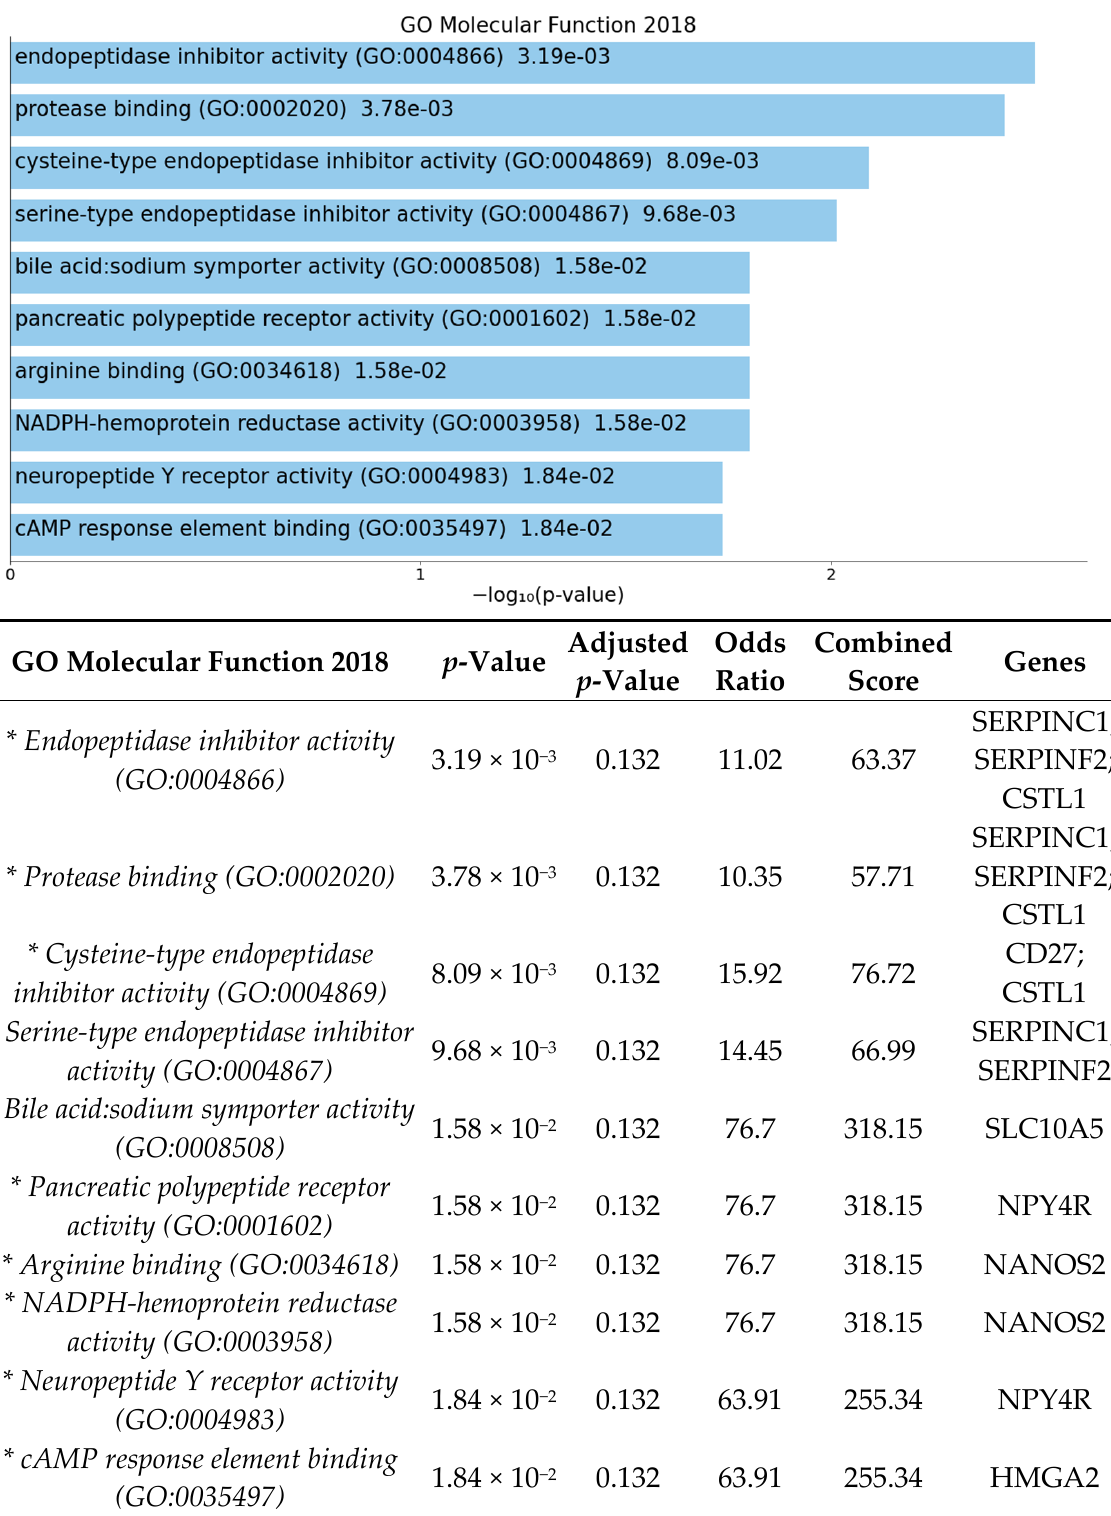
Figure 5. Gene list enrichment analysis of significant DEGs between GF-HFD mice ( n = 4) and GF-ND mice ( n = 4) using EnrichR. The bar graph shows a ranked list by p -value of the top 10 over-represented molecular functions with significant functions indicated in blue ( p -value < 0.05). The corresponding table demonstrates detailed statistics and involved genes with significant functions indicated by an asterisk ( p -value <